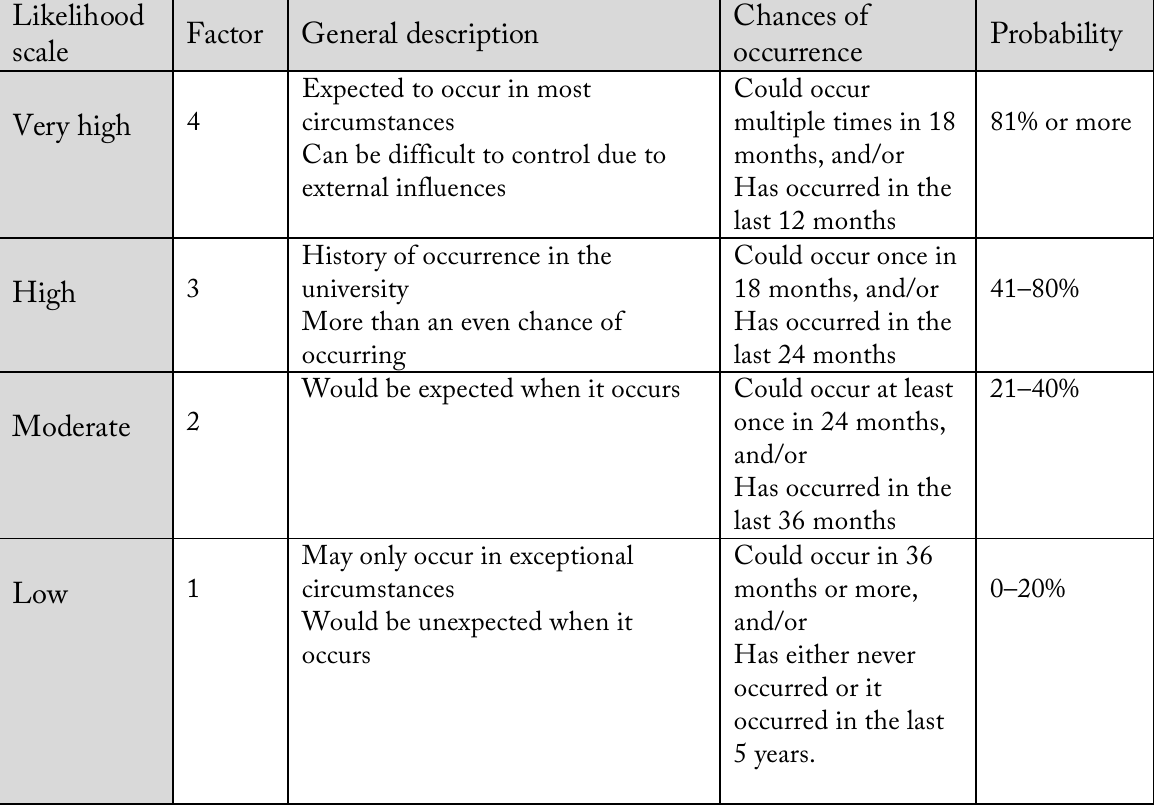
Table 3: The likelihood of risk to HEIs of a smothered caring human spirit